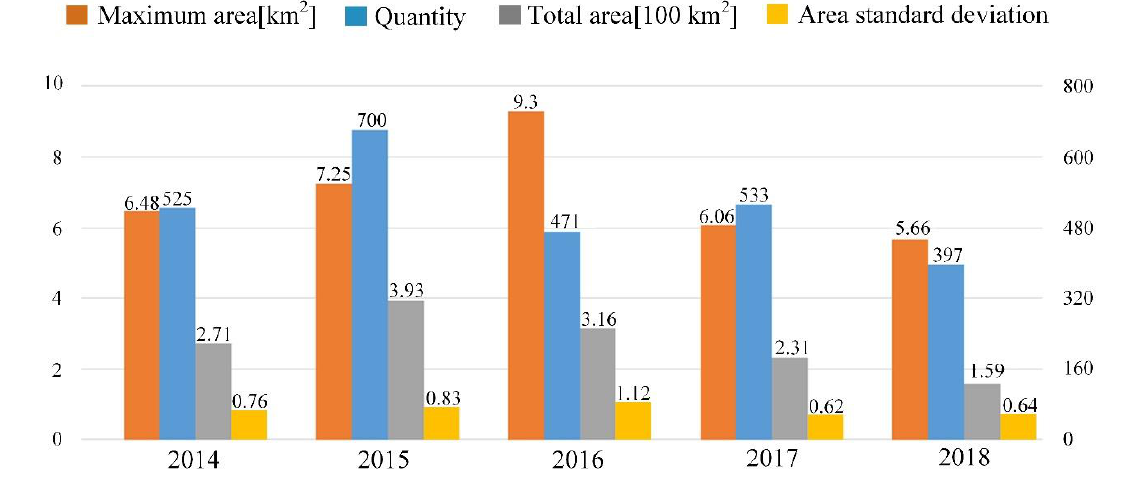
Figure 12. The basic information of extracted SGLs from 2014 to 2018.